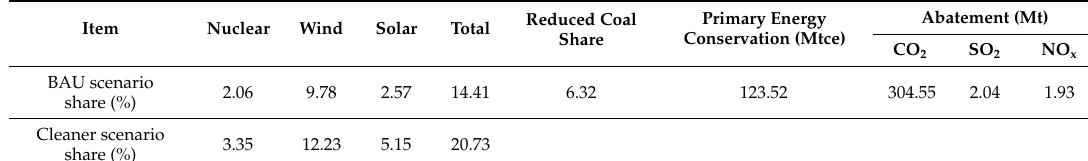
Table 9. Potential of alternative power generation in the cleaner scenario in 2020.